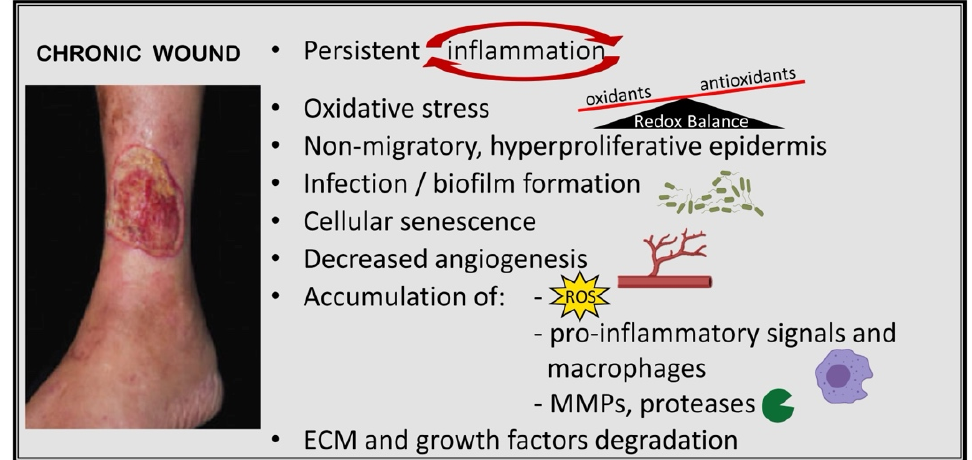
Figure 1. Pathologic abnormalities associated with delayed wound healing in chronic wounds. Persistent inflammation, as a hallmark of chronic wounds, is connected to the dysregulation of the immune response during wound healing by various factors and leads to excessive levels of pro-inflammatory signals, reactive oxygen species (ROS), changes in the proteolytic balance, and an increased amount of matrix metalloproteinases (MMPs) that eventually cause damage to the extracellular matrix (ECM) and impaired epithelialization and proliferation of keratinocytes. The molecular pathways and targets are summarized in Figure 2. The image of the chronic wound is reproduced from [10]. Reprinted with permission from AAAS, 2014.